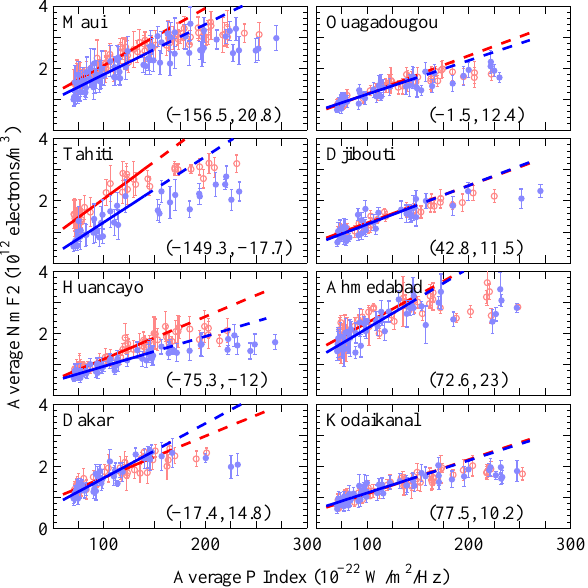
Fig. 4. Same as Fig. 2a but for low-latitude stations at different longitudes, and the values in parentheses are geographic longitudes and latitudes of the stations.